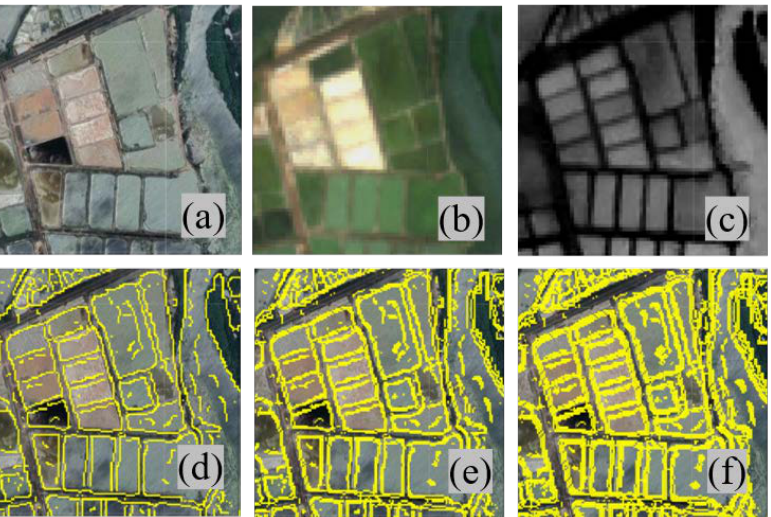
Figure 5. Example of the use of the proposed iterative algorithm to segment water pixels: ( a ) 0.5 m Hr-RSI: ( b ) 10 m Mr-RSI from Sentinel-2: ( c ) maximum NDWI image (MNI); ( d ) Canny edge image (CEI) generated from the MNI at the first iteration, where a few aquaculture ponds are segmented completely; ( e ) CEI at the second iteration, where most aquaculture ponds are segmented completely; ( f ) CEI at the third iteration, where all the aquaculture ponds are segmented